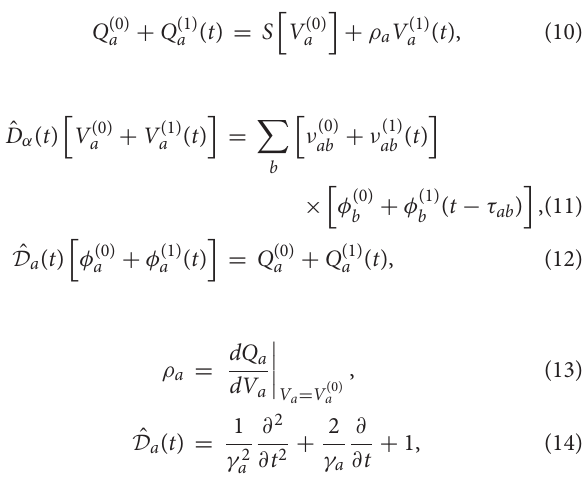
and Schüz, 1998), assuming that synaptic types are determined by the source neurons. Forward time delays are τ es for thalamocortical signals and feedback delays are τ se